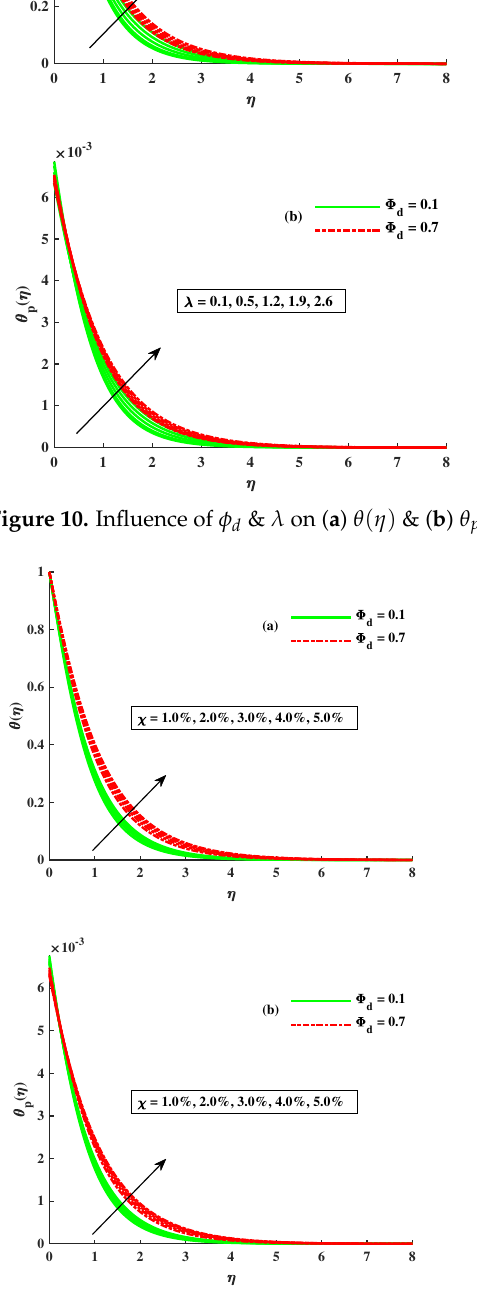
Figure 11. Influence of φ d & χ on ( a ) θ ( η ) & ( b ) θ p ( η ) . For the various entries of the rotational factor, magnetic parameter, and dust-particle- density component, the skin friction factor is shown in Figure 12a,b in the x and y -axes. Figure 12a demonstrates that C f x (skin friction coefficient) is decreased when the values of M , R , & φ d are increased, while Figure 12b demonstrates that the C f y depreciates